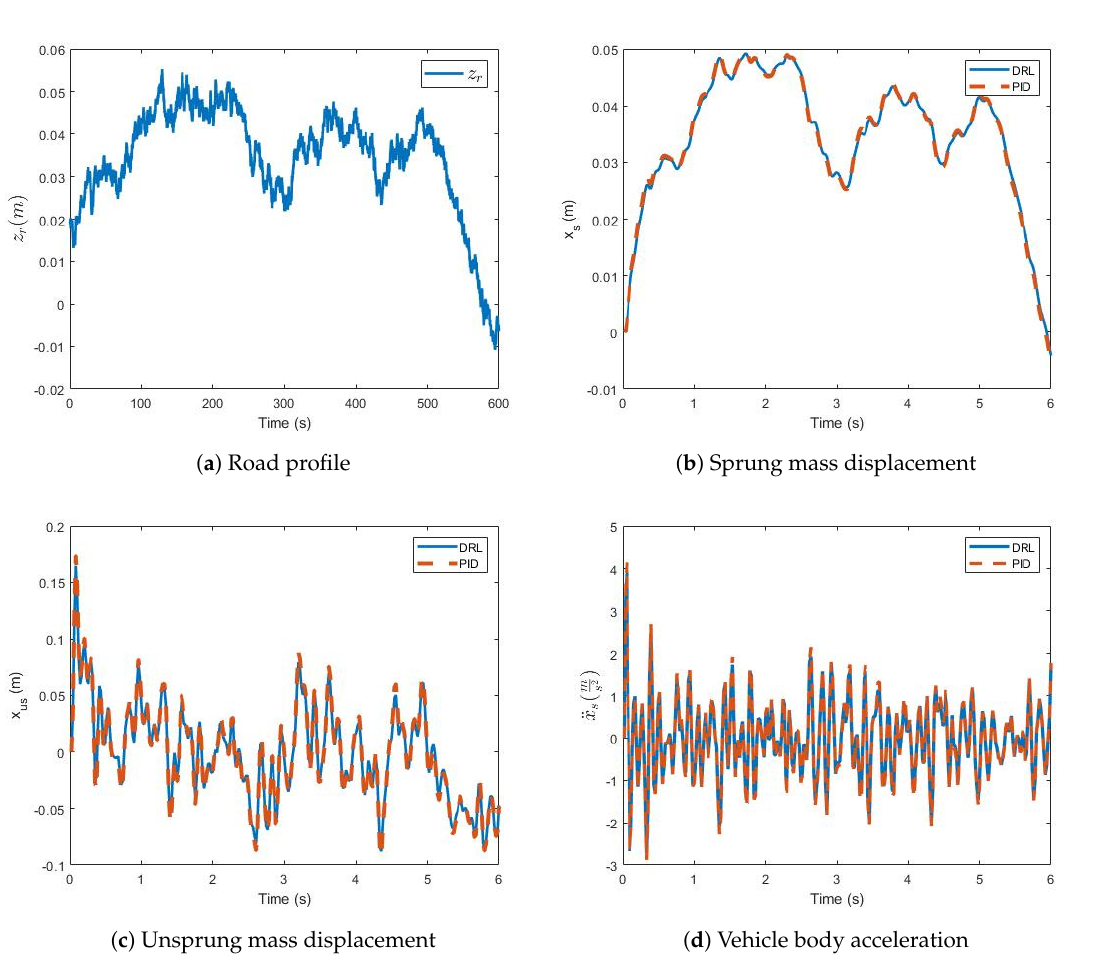
Figure 8. Scenario 2.